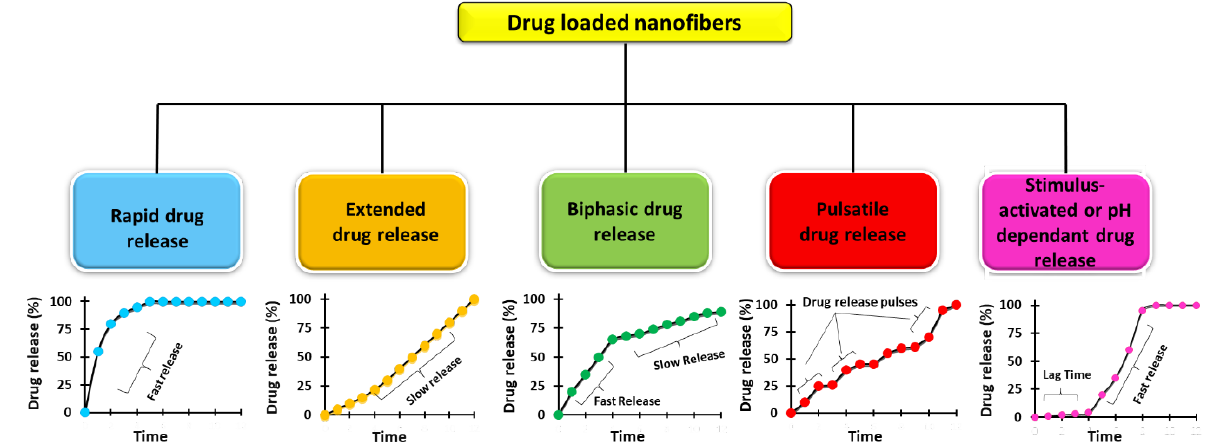
Figure 1. Drug release profiles of various nanofibre-based drug delivery systems.